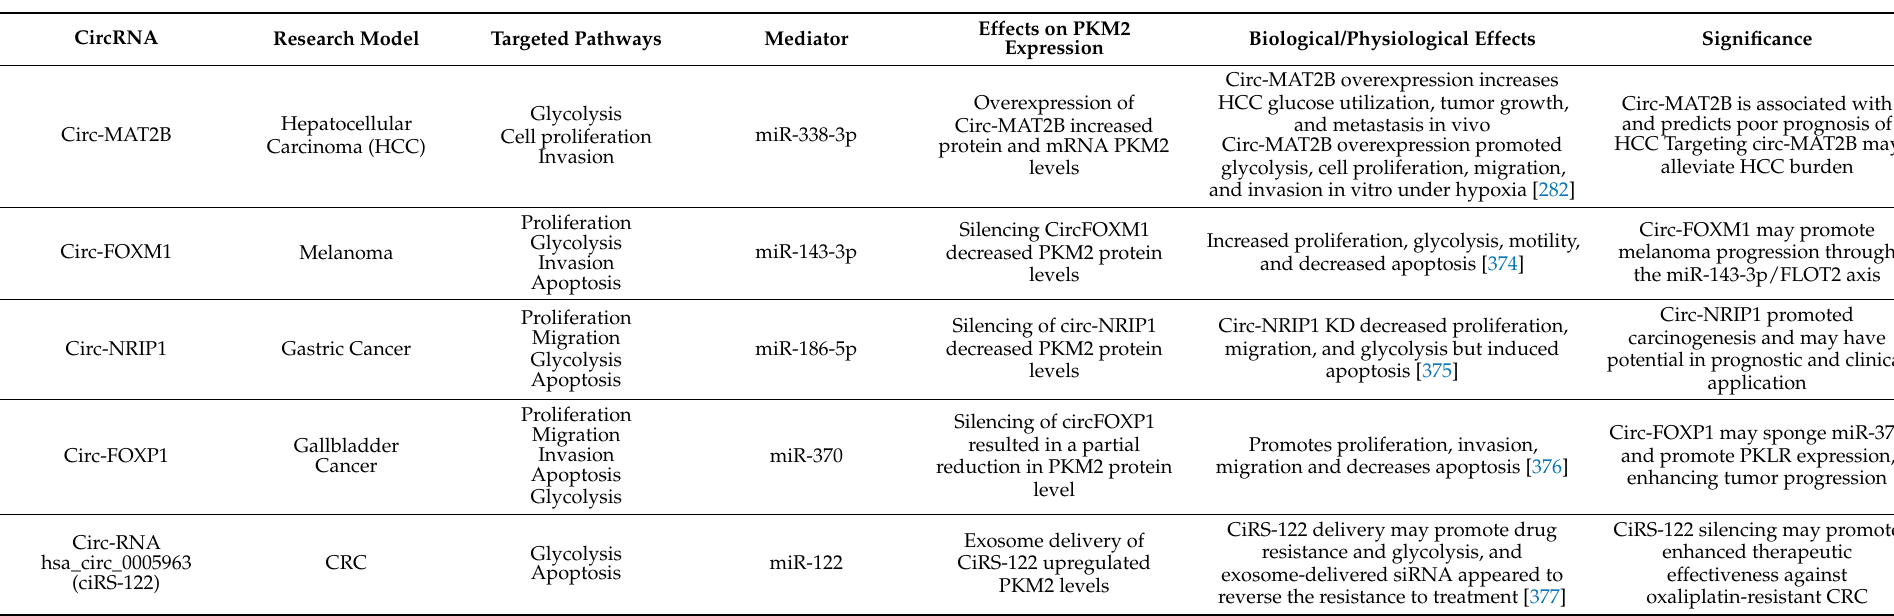
Table 5. Roles of CirRNAs associated with PKM2 in